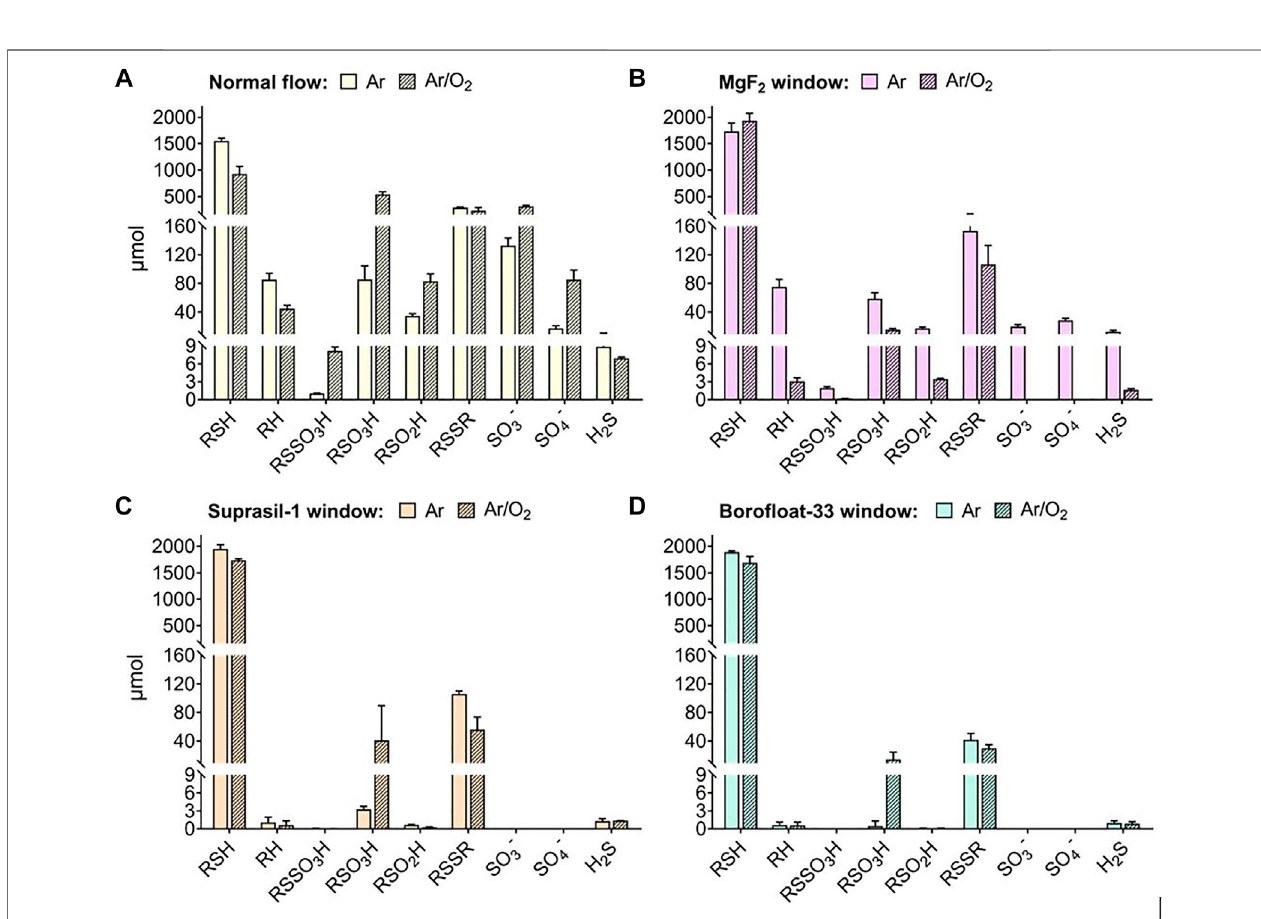
FIGURE 6 | Plasma-induced formation of cysteine derivatives (1 min treatments), using a 3 slm Ar ± O 2 and 5 slm N 2 shielding gas. Solutions treated in 24 well plates(750 μ L,freeplasma, (A) orradiationmicro-chamber(80 μ L,see Figure1 , (B – D) ).Quanti fi cationperformedusingderivatizationwithmonobromobimaneandRP- SRM for H 2 S (according to [60]), using IC for SO 42- and SO 32- and HILIC-MRM for the other compounds; experiment performed in triplicates.